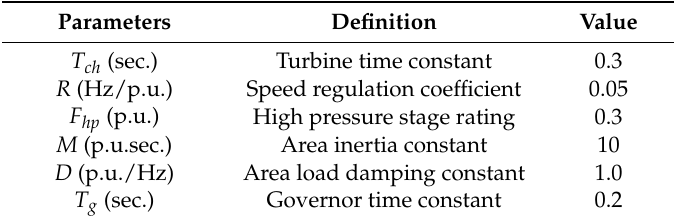
Table A1. System parameters for Figure 5.